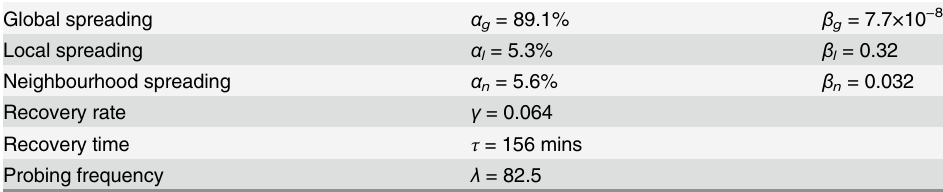
Table 1. Conficker parameters inferred from data 1